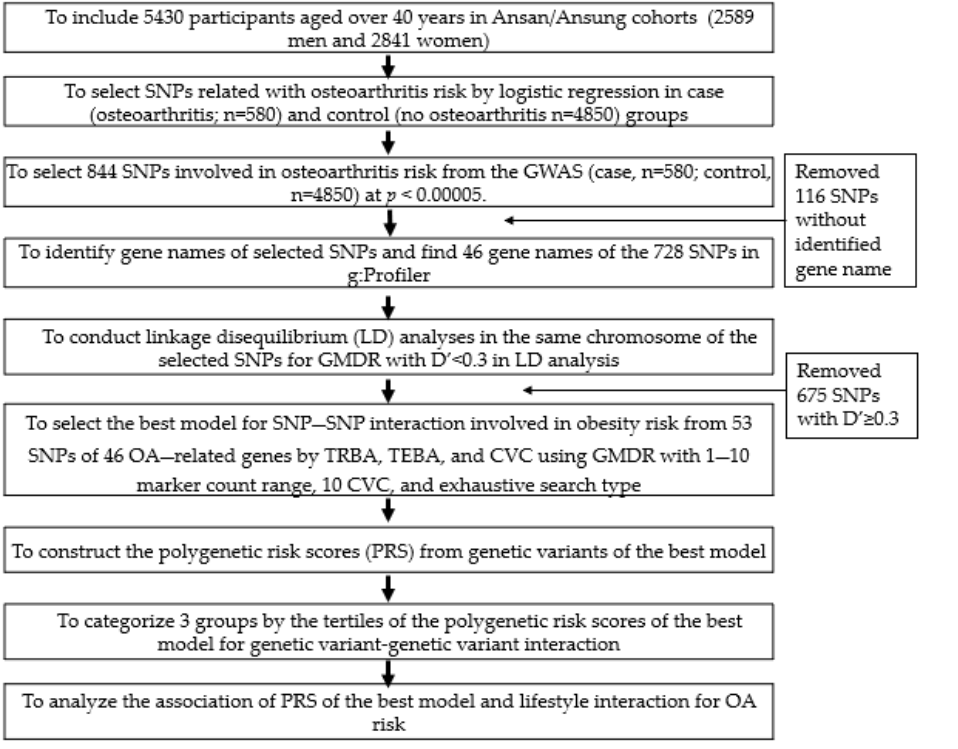
Figure 1. Flow chart for generating polygenetic variants with genetic variant-genetic variant interactions that influence osteoarthritis risk and to explore the interactions between polygenetic risk scores (PRS) and lifestyle.